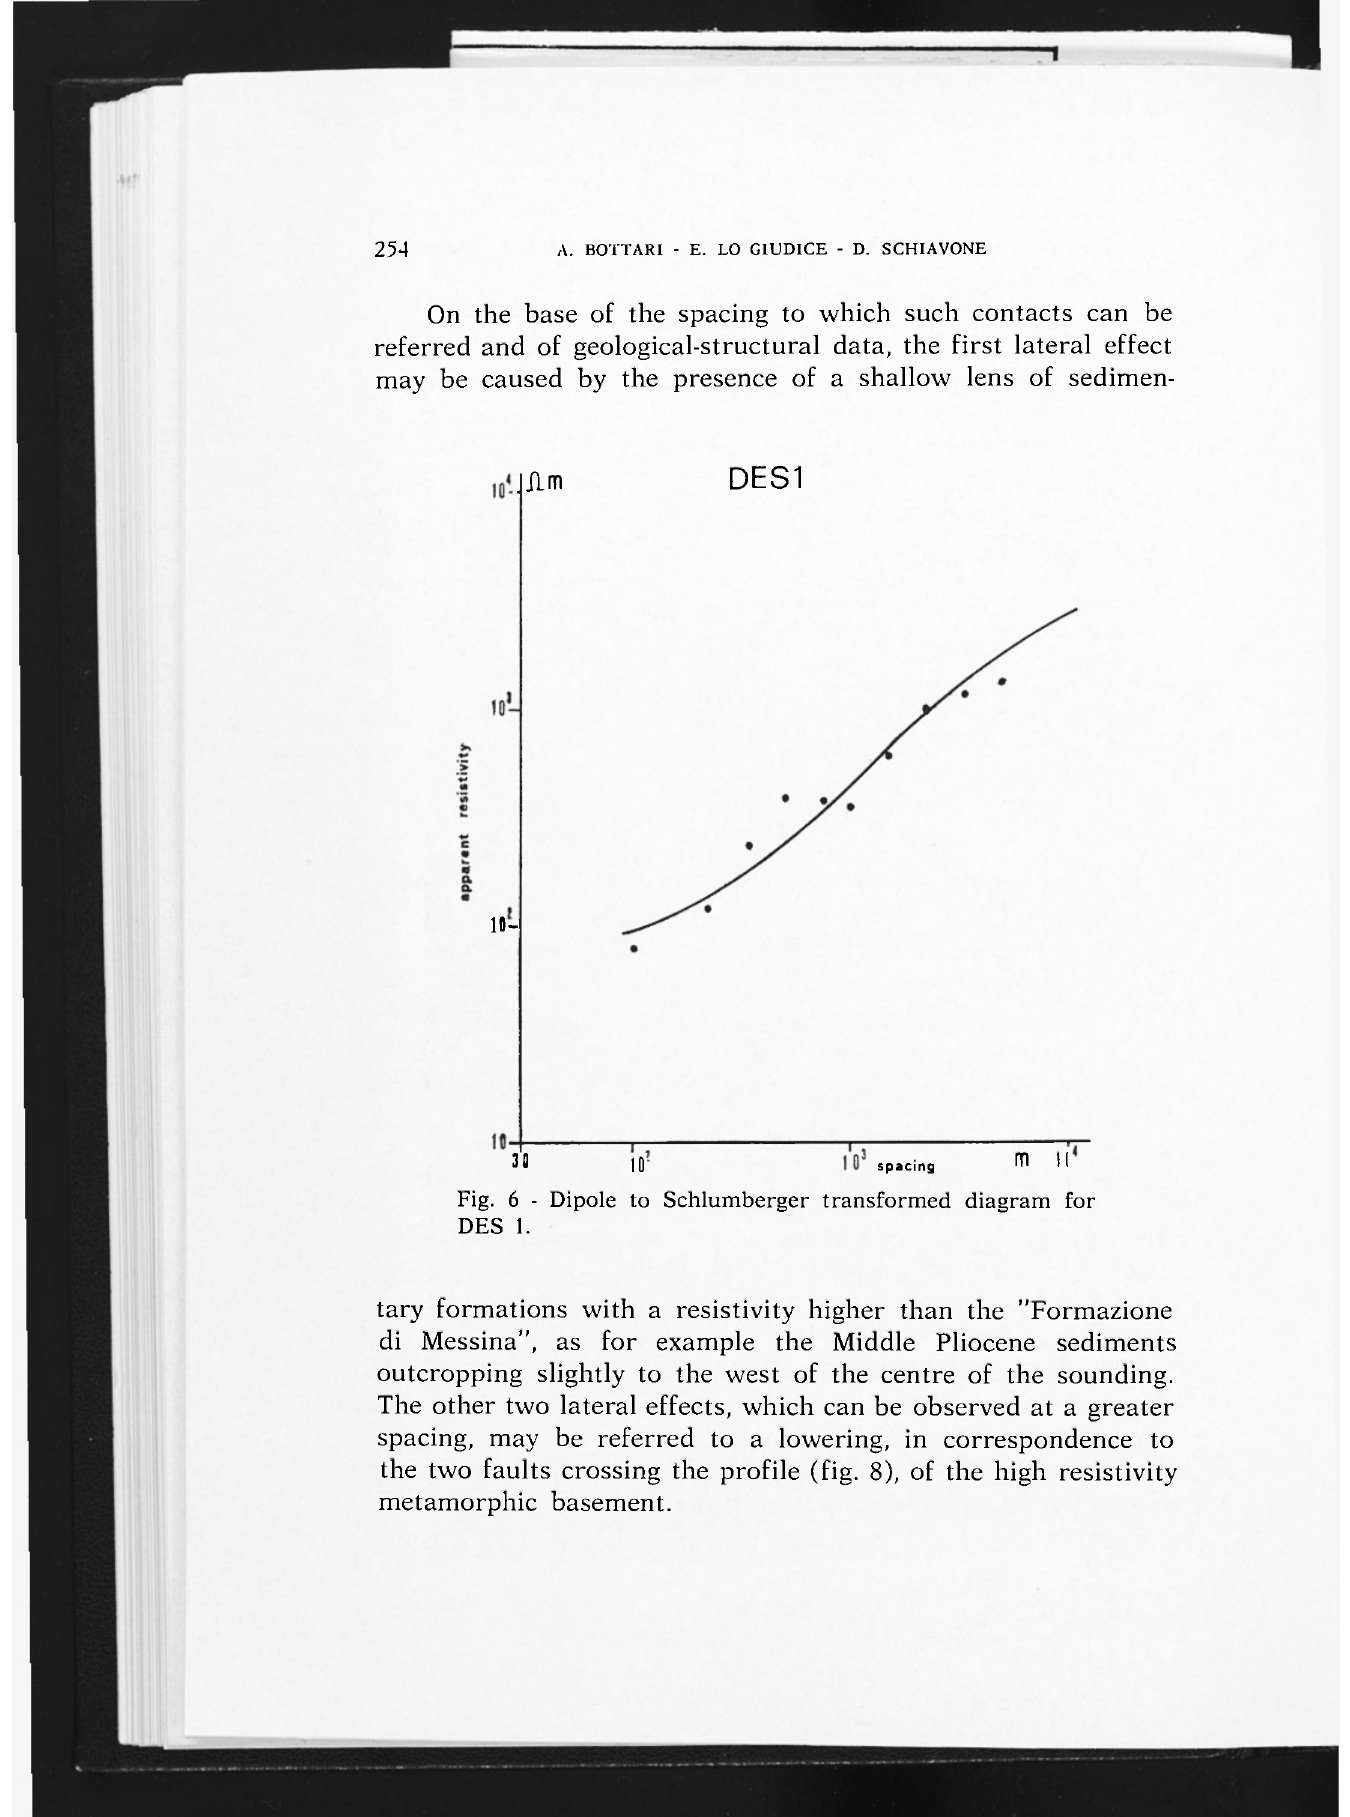
Fig. 6 - Dipole to Schlumberger transformed diagram for DES